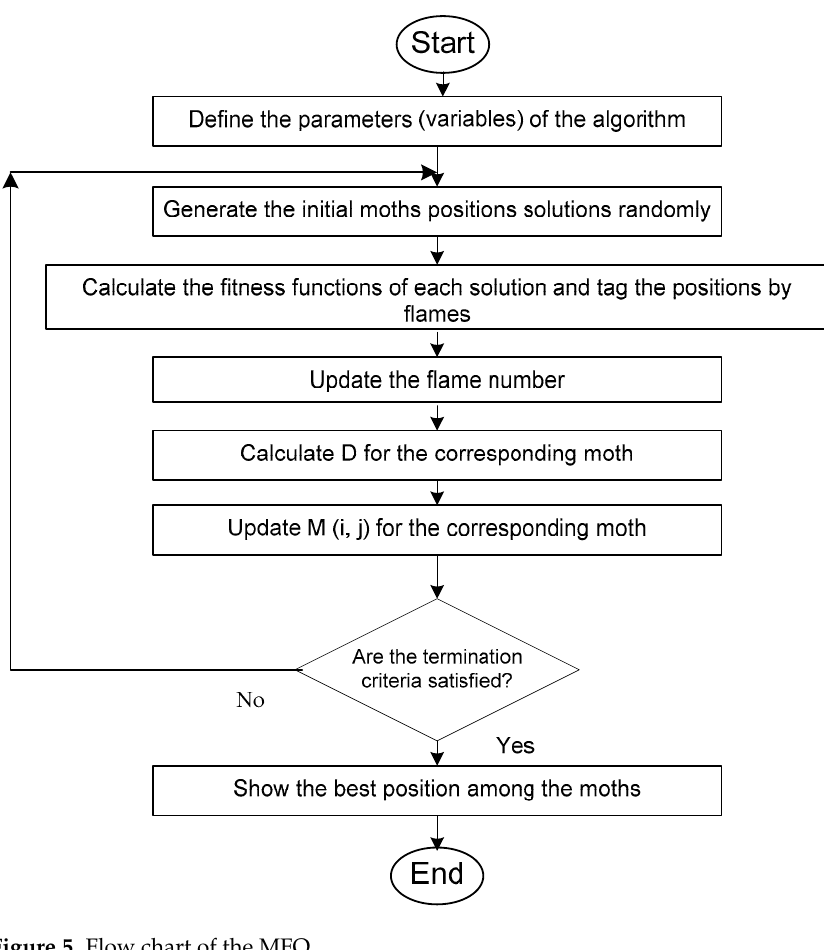
Figure 5. Flow chart of the MFO .